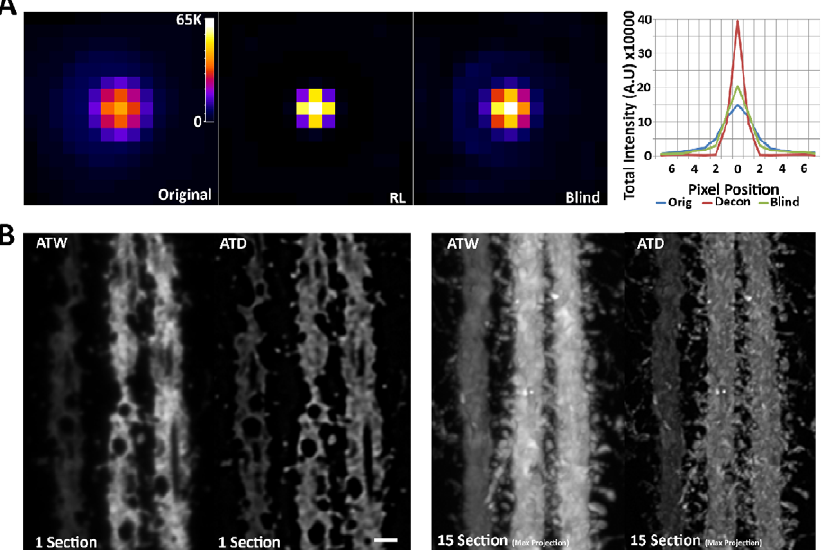
Figure 2. Two-dimensional Richardson-Lucy deconvolution of array tomographic images. (A) Comparison of RL deconvolution with empirical PSF versus blind deconvolution using an initial Gaussian PSF on a single sub-diffraction bead. Both methods are intensity conserving, while RL using an empirical PSF does a much better job of returning the light back to the central pixel. The graph is a plot of the sum of intensities across each column of pixels in the images. Note the conservation of intensity and the dramatic increase in central intensity in the RL plot. (B) Single section and Max projection of AT reconstructed YFP dendrite before and after two-dimensional deconvolution. Spines are clearly resolved in the deconvolved image. Scale bar=1